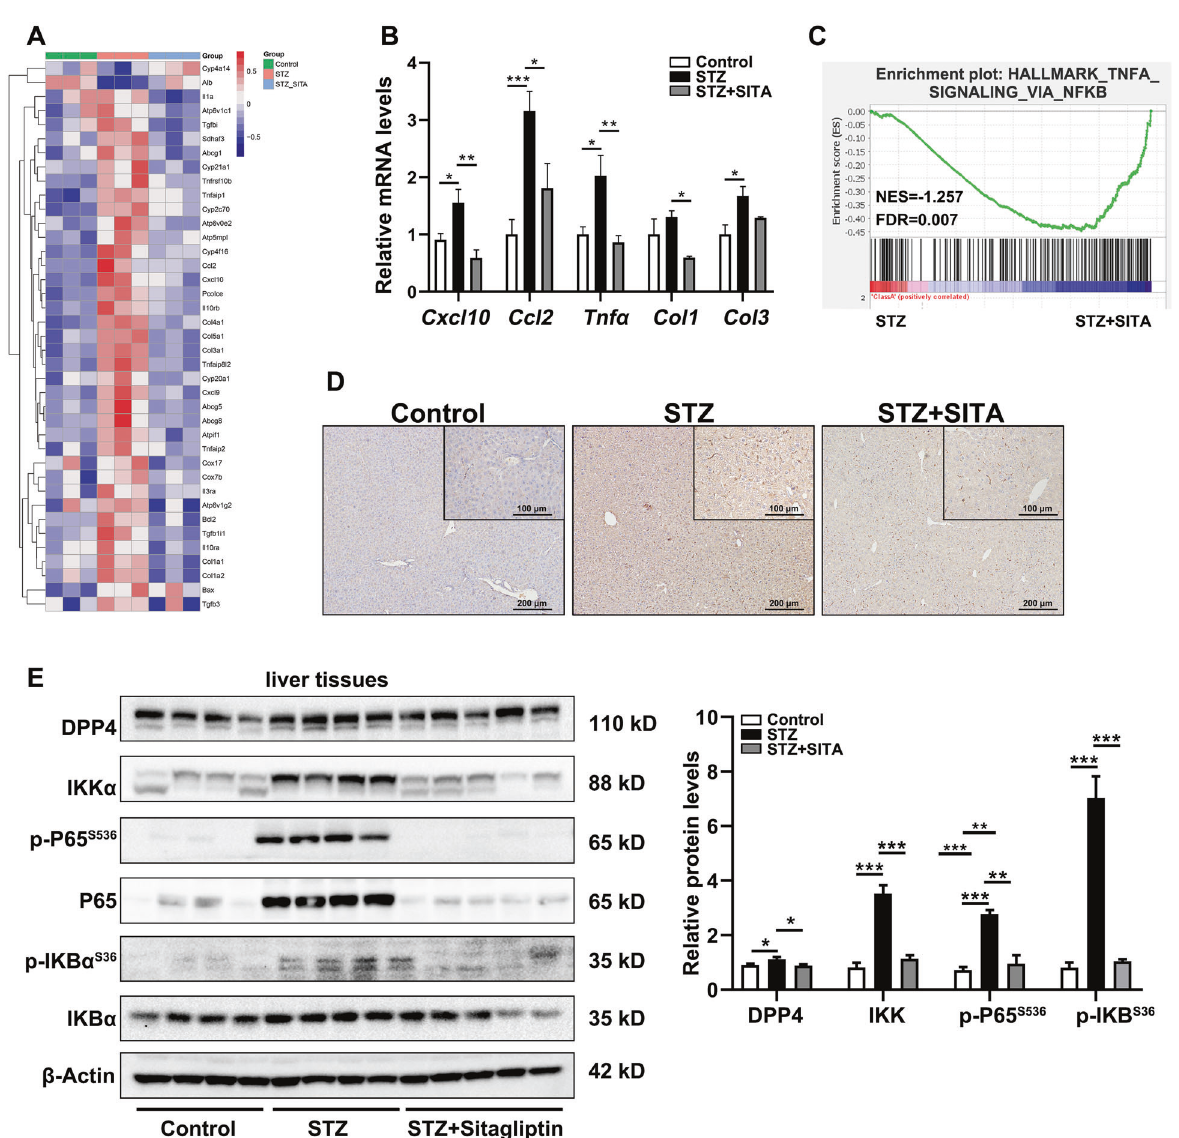
Fig. 4 Sitagliptin downregulates NF κ B pathway during liver in fl ammation in STZ-induced diabetic mice. A RNA-seq heatmap of the expression of mentioned genes in liver tissues of STZ-induced diabetic mice. B Real-time PCR analysis of Cxcl10 , Ccl2 , Tnf α , Col1 , and Col3 levels in diabetic mice with or without sitagliptin treatment. C Gene signatures for NF κ B activation (HALLMARK_TNFA_SIGNALING_VIA_NFKB) were enriched within STZ group comparing with STZ + SITA group. D F4/80 staining of liver tissues (scale bar 100 and 200 μ m) in STZ-induced diabetic mice with or without sitagliptin treatment. E Western blottings and quantitative analysis of the effects of sitagliptin on the protein levels of DPP4, IKK α , p-P65 S536 , P65, IKB α , and p-IKB α S36 in mice liver tissues ( n = 5 mice per group). The results are presented as mean ± SEM of three independent experiments; * P < 0.05, ** P < 0.01, *** P <